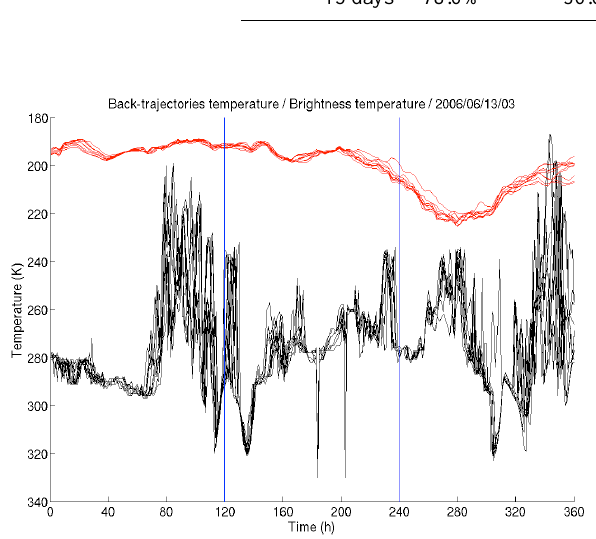
Fig. 16. Evolution of local temperature (red) and coldest brightness temperature from ISCCP (black) along the ten back-trajectories mapped in Fig. 15, as a function of time before SVC detection.